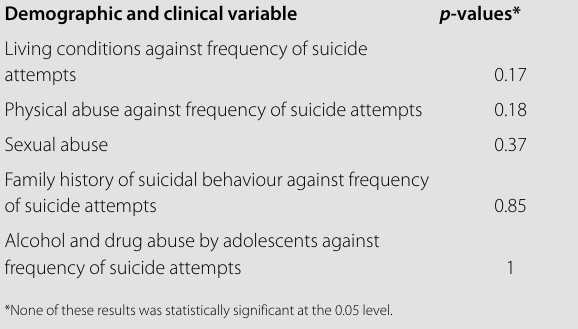
Table 1. Fisher’s exact test to assess the association between demographic and clinical variables, and frequency of suicide attempts Demographic and clinical